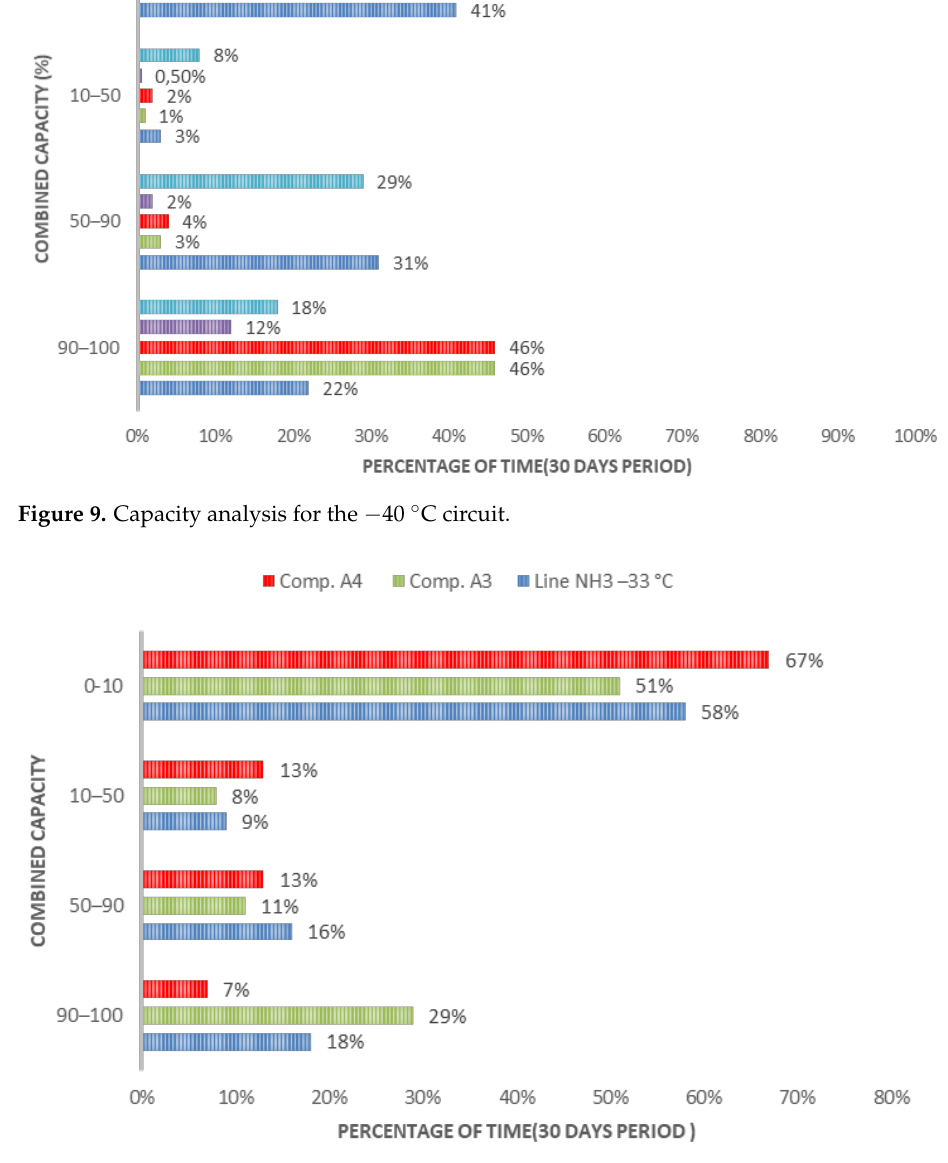
Figure 10. Capacity analysis for the −33 °C circuit.